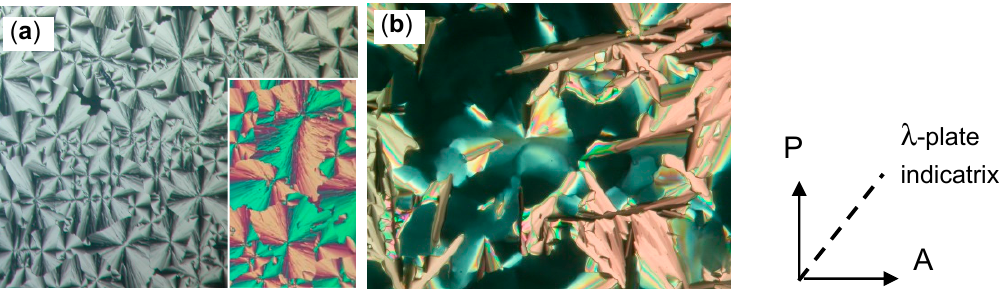
Figure 5. Representative textures of the Col hex phases of compounds C m/m , as observed between crossed polarizers between glass plates with approximately the same distance of 15 μ m in ( a , b ); ( a ) C4/4 at T = 165 °C, and ( b ) C12/12 at T = 170 °C. The inset in ( a ) shows the texture with additional λ -retarder plate, the blue-shifted fans (green color) are parallel to the main indicatrix direction and thus define the orientation of the high-index axis as radial rather than tangential within the spherulitic domains. Because in these spherulites the columns are known to be tangential (forming cycles around the central defect), and the high-index axis parallel to the OPE long axis, it follows that the OPEs are perpendicular to the columns; this indicates negative birefringence. At the right, the orientation of polarizer (P) and analyzer (A) and the slow axis orientation of the λ -plate are shown.